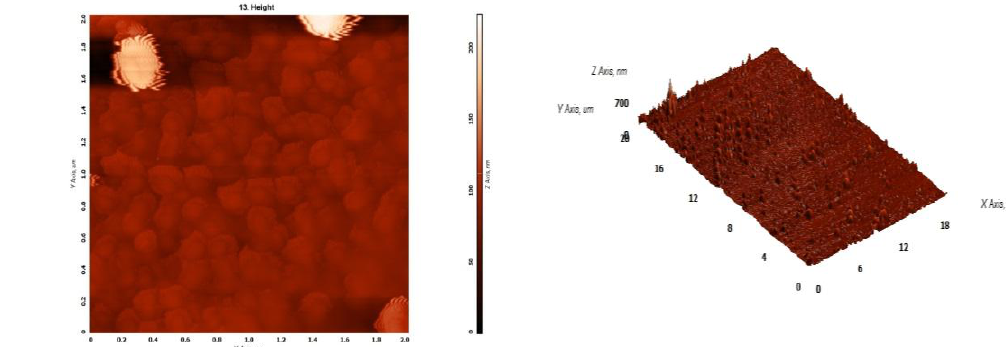
Figure 14: AFM image (F6).